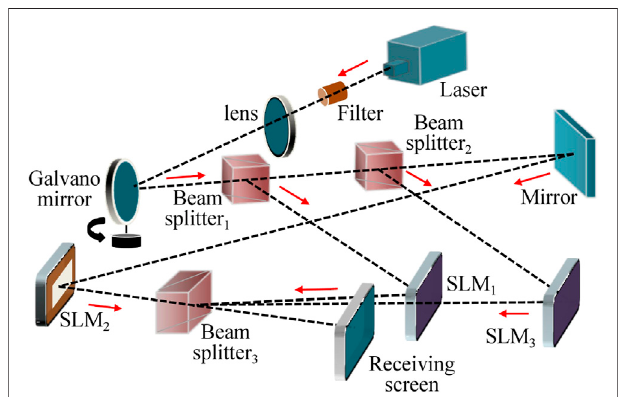
FIGURE 5 | Structure of the reconstructed